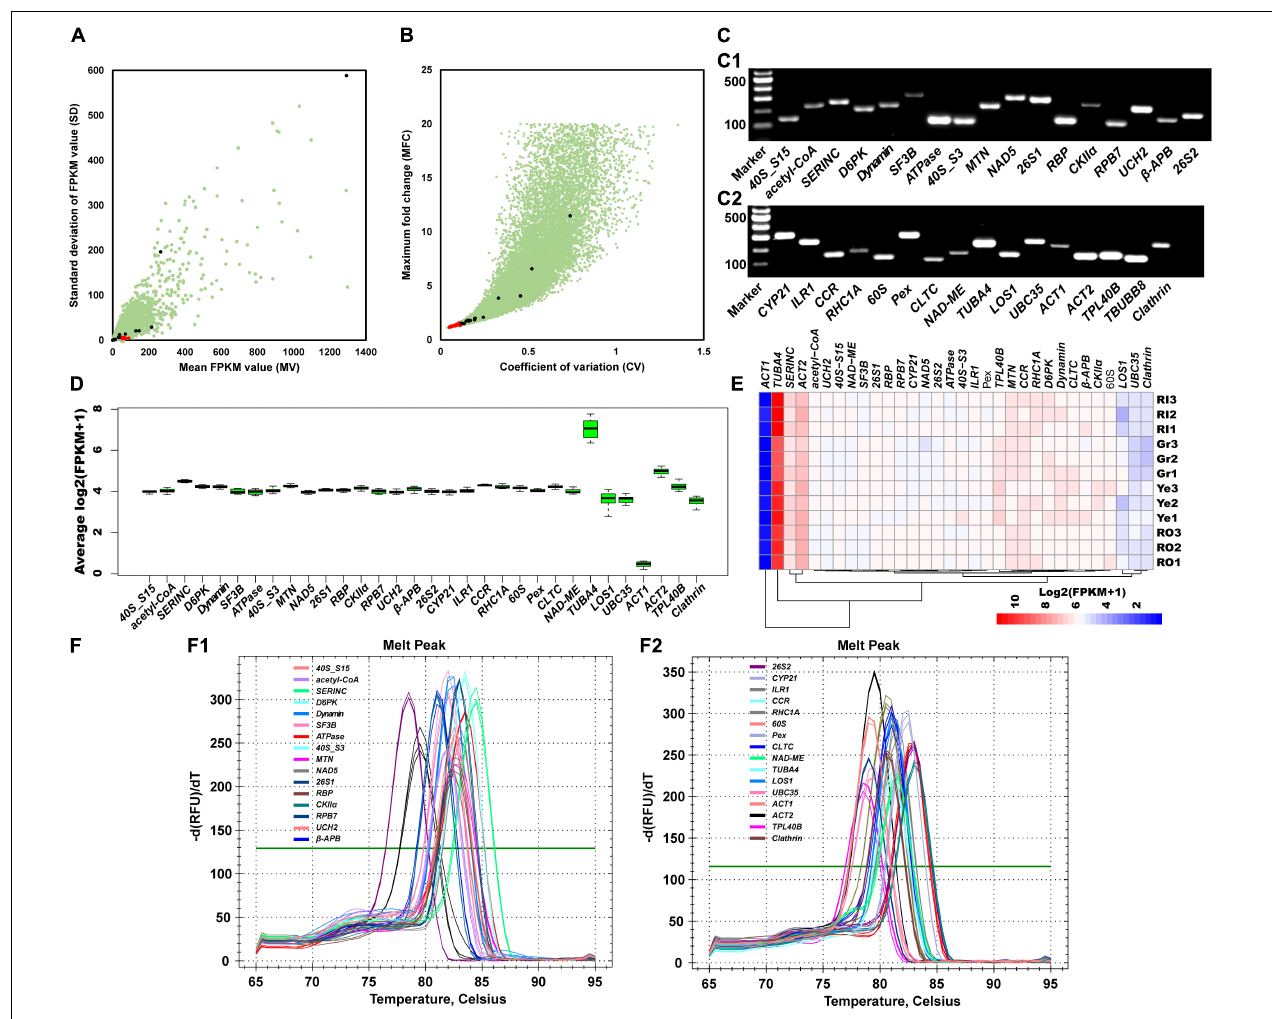
FIGURE 1 | Selection of candidate reference genes. (A) SD (standard deviation of FPKM value), MV (mean value of FPKM) values, and (B) MFC (maximum fold change) and CV (coefficient of variation) values are used to indicate the expression stability of 32 selected candidate reference genes. Red dots represent the 29 selected stable expression genes, black dots represent the 13 commonly used reference genes, and green dots represent the other genes. (C) Primers’ specificity is confirmed by resolving PCR products on an agarose gel. Marker, Marker I. The other lanes belong to the PCR products of candidate reference genes. (D) Expression stability overview of 32 selected candidate genes. Box and whisker plot graphs show log 2 (FPKM + 1) values of each selected gene under different treatments in multiple tissues. Black boxes and lines represent the 25th and 75th percentiles and medians, respectively. Whisker caps represent the maximum and minimum values. (E) Gene expression levels under different conditions. RI, Gr, Ye, and RO represent ginger samples collected from the inner red stem part, the green stem, the young yellow rhizome, and the red stem surface part. (F) Melting peak and melting curve of 32 primers of corresponding candidates to confirm the